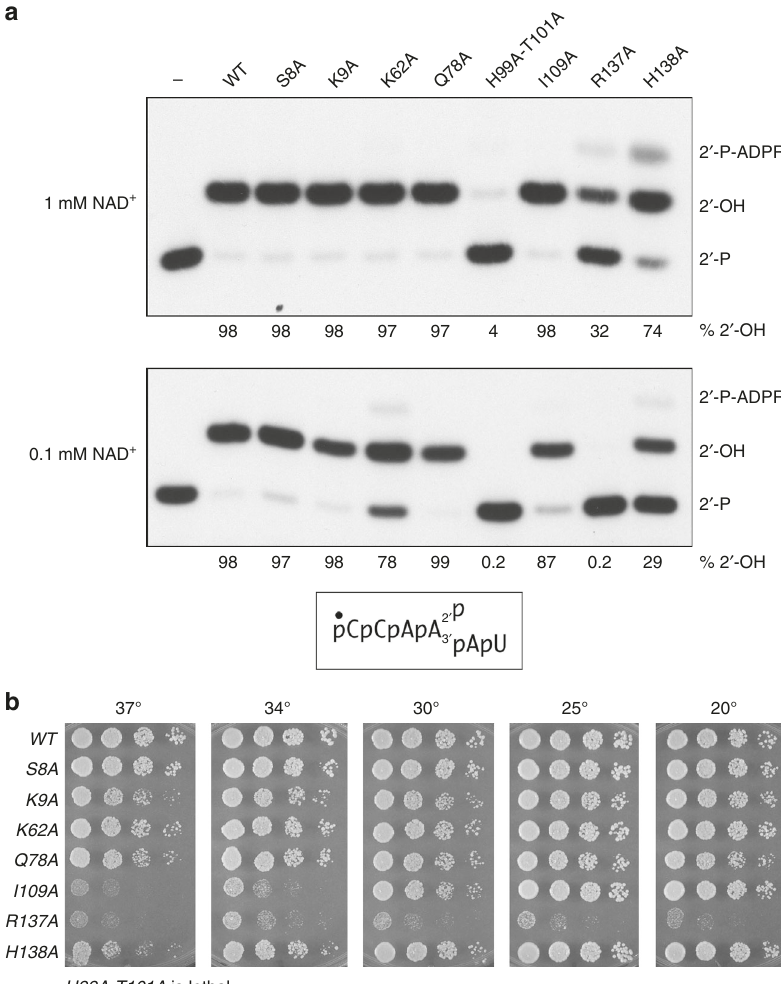
Fig. 6 Structure-guided mutagenesis. a Reaction mixtures containing 100 mM Tris-HCl (pH 7.5), either 1 mM or 0.1 mM NAD + as speci fi ed, 0.2 µ M (2 pmol) 5 ′ 32 P-labeled 6-mer 2 ′ -PO 4 RNA (shown at bottom), and 0.01 µ M (0.1 pmol) wild-type or mutant RslTpt1 as speci fi ed were incubated for 30 min at 37 °C. Tpt1 was omitted from the control reaction mixture in lane – . The reaction products were analyzed urea-PAGE and visualized by autoradiography. The positions of the 6-mer 2 ′ -PO 4 RNA substrate (2 ′ -P), 2 ′ -P-ADPR RNA intermediate, and 2 ′ -OH RNA product (2 ′ -OH) are indicated on the right. The extents of 2 ′ -OH RNA product formation (expressed as percent of total labeled RNA) are indicated below the lanes. b tpt1 Δ complementation was performed by plasmid shuf fl e as described under Methods. Serial dilutions of the indicated S. cerevisiae tpt1 Δ RslTPT1 strains were spot-tested for growth